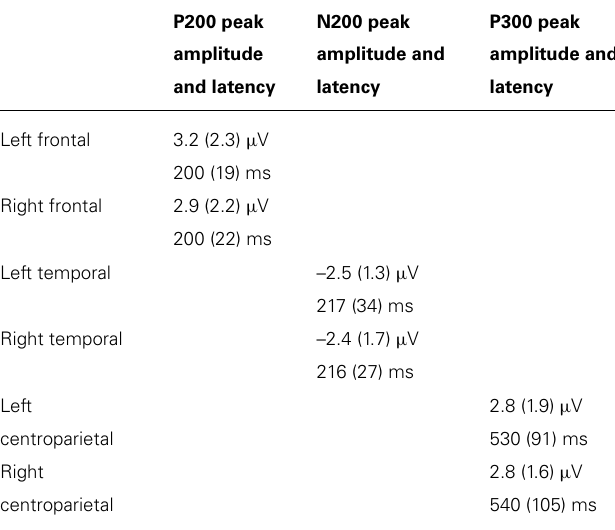
Table 1 | Mean (SD) ERP scores for negative stimuli in each region.